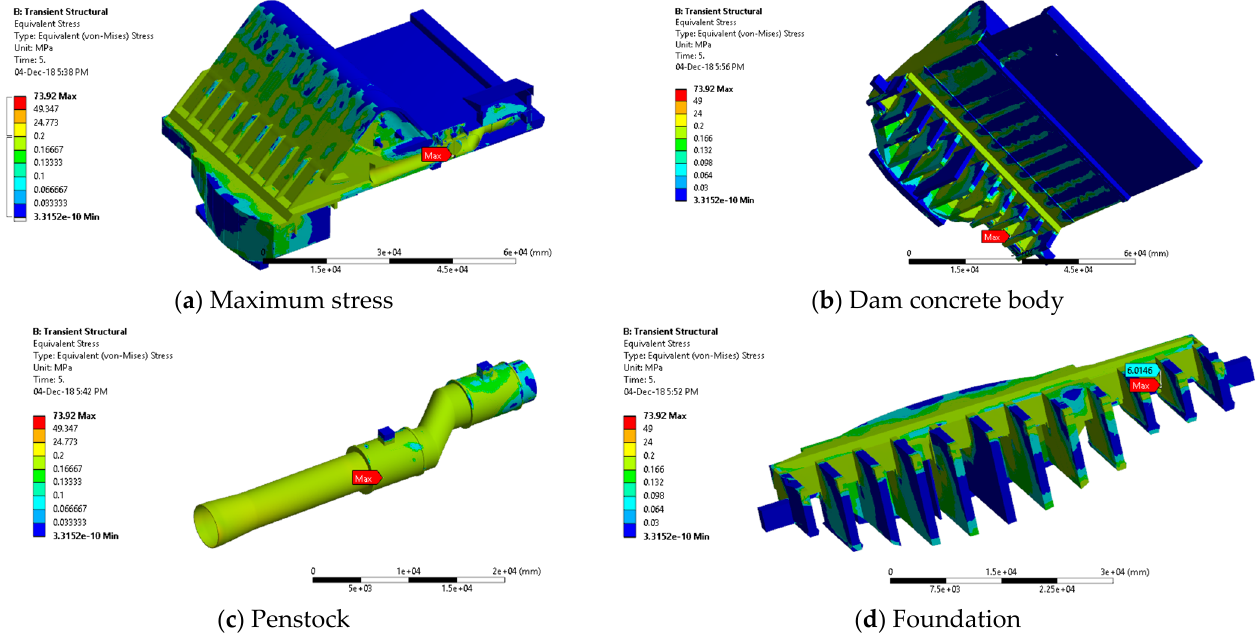
Figure 12. Bottom outlet operates at Case 1.